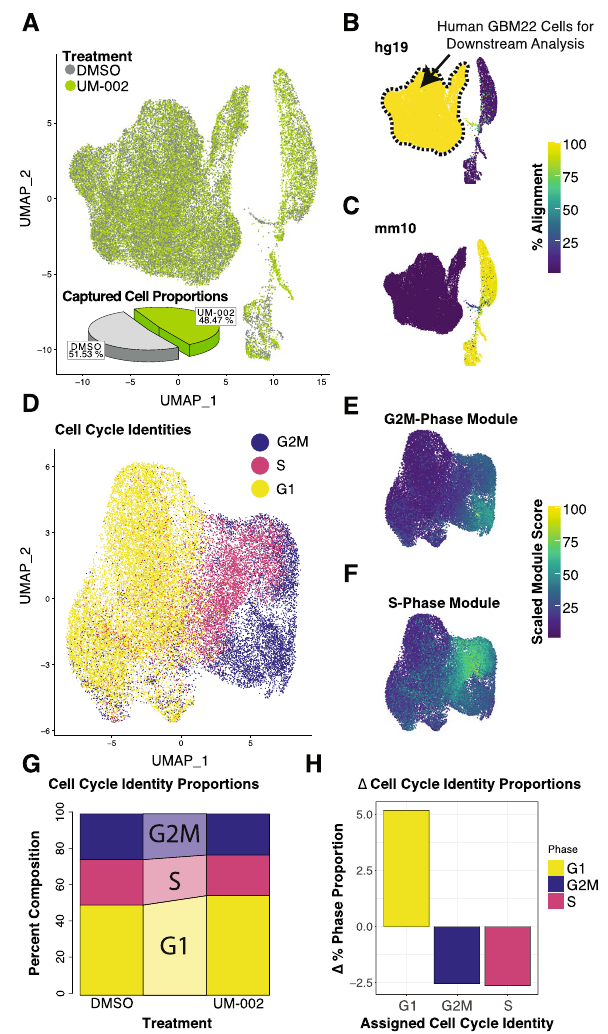
Figure 5. UM-002 induces changes in cell cycle related gene expression at single-cell resolution in vivo. ( A ) UMAP plot of the 38,200 total high-quality cell transcriptomes captured from both DMSO (gray) and UM-002 (green) treated PDX tumors. Cells are from tumors from 3 mice per treatment group. From DMSO treated mice, 18,452 cell transcriptomes were captured, while 19,748 were captured from UM-002 treated mice. ( B , C) The GBM22 population of cells can be identified through analysis of individual cell percent alignment to hg19 (human) transcriptome (B), and percent alignment to mm10 (mouse) transcriptome. (C). ( D ) UMAP plot with pass-filter GBM22 cell transcriptomes (28,874 total GBM22, 14,878 DMSO treated, 13,996 UM-002 treated), colored by assigned cell cycle phase identity as determined using the R package Seurat 52–55,59 . ( E ) UMAP of GBM22 cell transcriptomes colored by G2M phase expression module score. ( F ) UMAP plot of GBM22 cell transcriptomes colored by S phase expression module score. ( G ) Connected bar plot showing the relative proportions of cells within G1, S, and G2M phases in DMSO and UM-002 treated tumors. ( H ) Bar plot showing changes in relative proportions (as percent) of cells within each phase of the cell cycle in UM-002 treated vs DMSO treated PDX